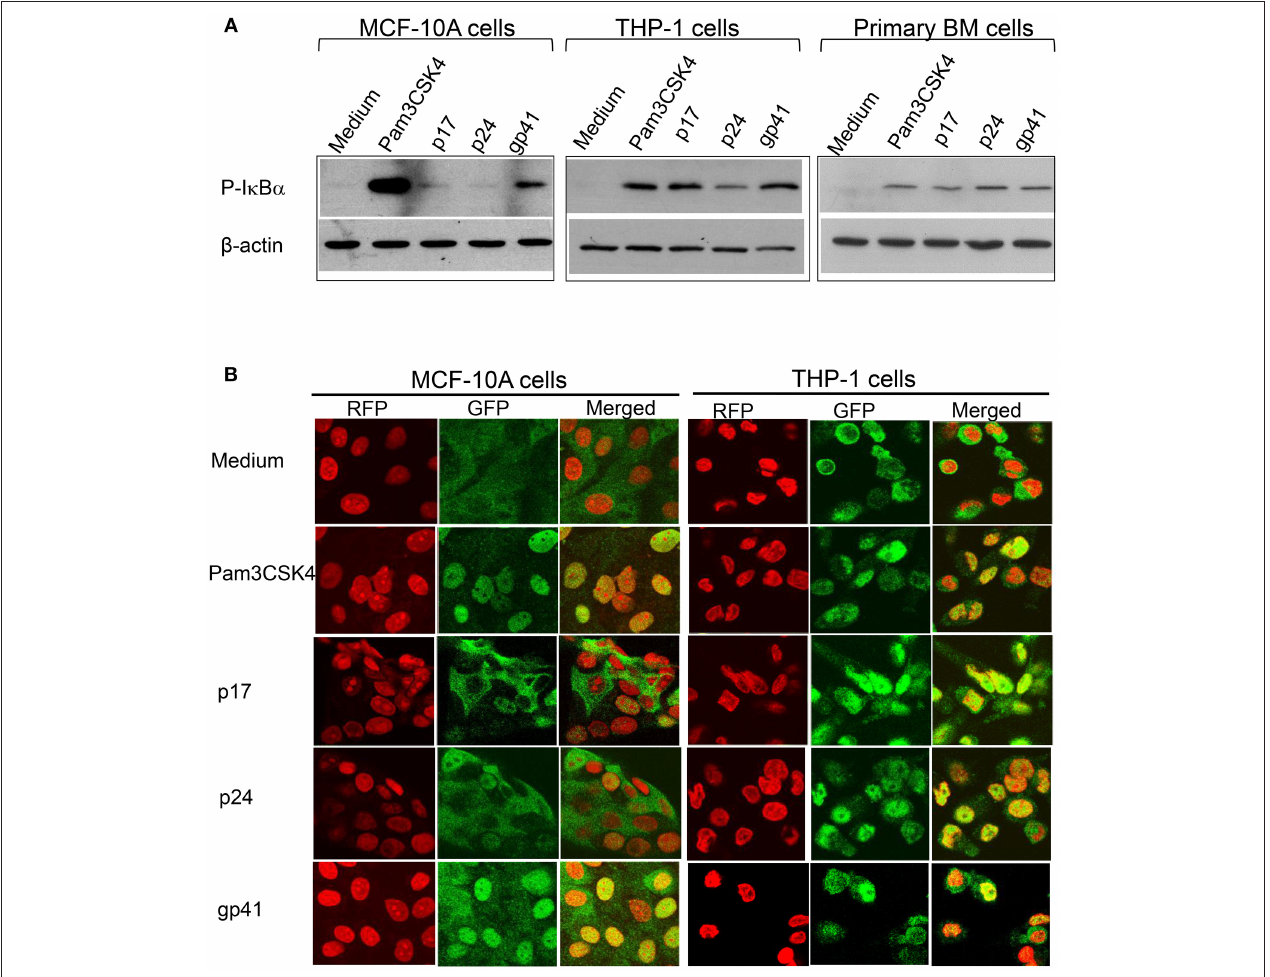
FIGURE 7 | HIV-1 proteins lead to NF- κ B α activation (A) Western blot analysis of the cell lysates extracted from MCF-10A, THP-1, and primary BM cells treated with HIV-1 proteins and detected with an antibody against the active NF- κ B α subunit, phospho(P)-I κ B α , with anti β -actin used as the loading control on the same membranes (B) Confocal microscopy of HIV-treated MCF-10A and THP-1 cells fixed and stained with an anti- NF- κ B α subunit p65 antibody and visualized with a second antibody, anti-rabbit-IgG-alexa488 (GFP; green), p65 was translocated upon activation into the nuclei (RFP; red with propidium iodide staining) displayed in yellow